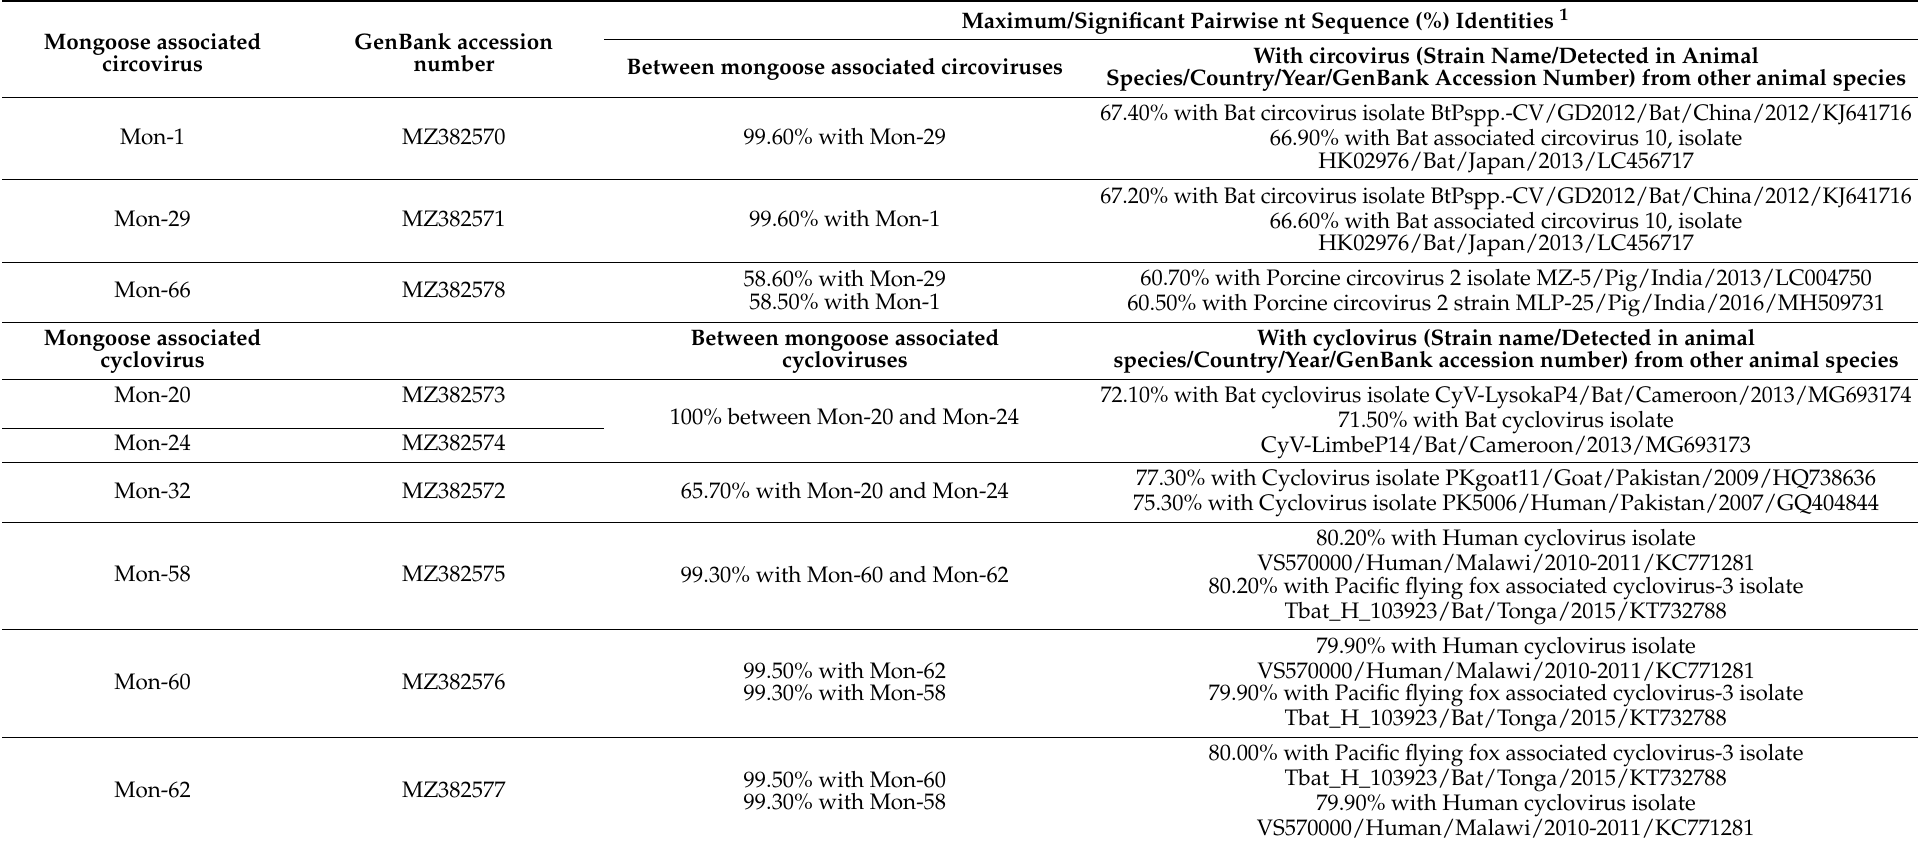
Table 2. Maximum/significant pairwise nucleotide (nt) sequence identities of the complete genomes of mongoose associated circoviruses and cycloviruses between themselves and with those from other animal